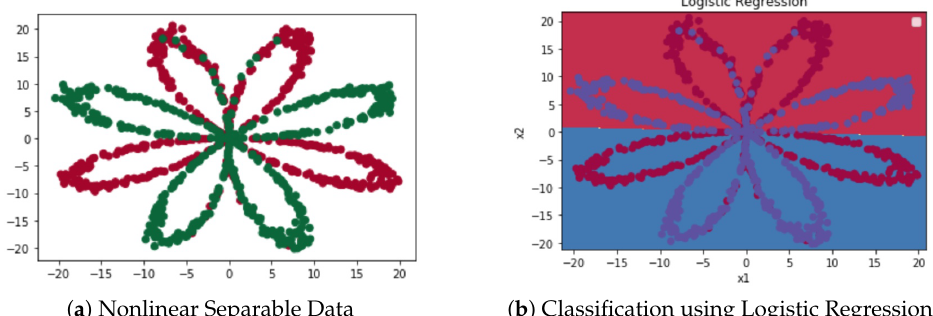
Figure 4. Classification of nonlinear data using logistic regression